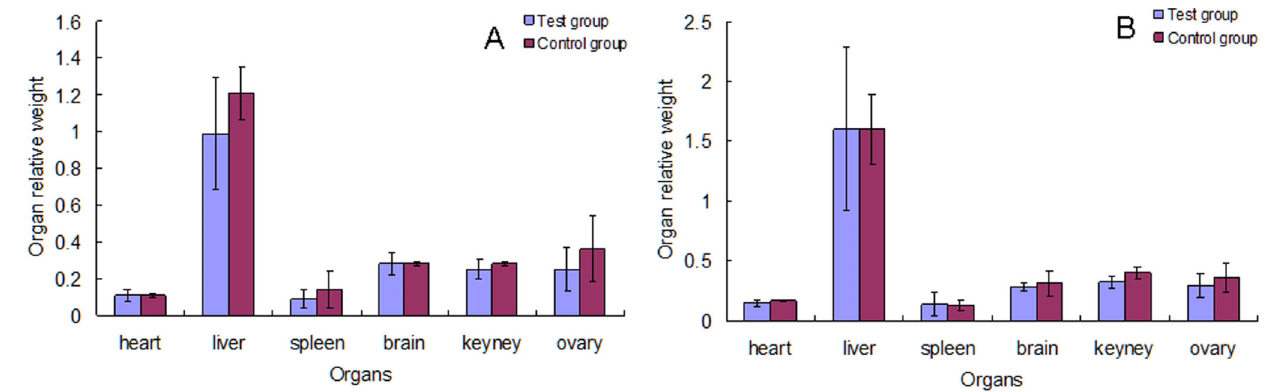
Figure 5. Effect of Cry1Ab protein on the organ relative weight of Swiss rat. The organ relative weight was calculated by organ weight/ body weight. The body weight of rat was weighed before the rat was dissected and the organ weight of rat was weighed after the rat dissection. A: the organ relative weight in Swiss rat that feeding for 30 days. B: the organ relative weight in Swiss rat that feeding for 90 days.